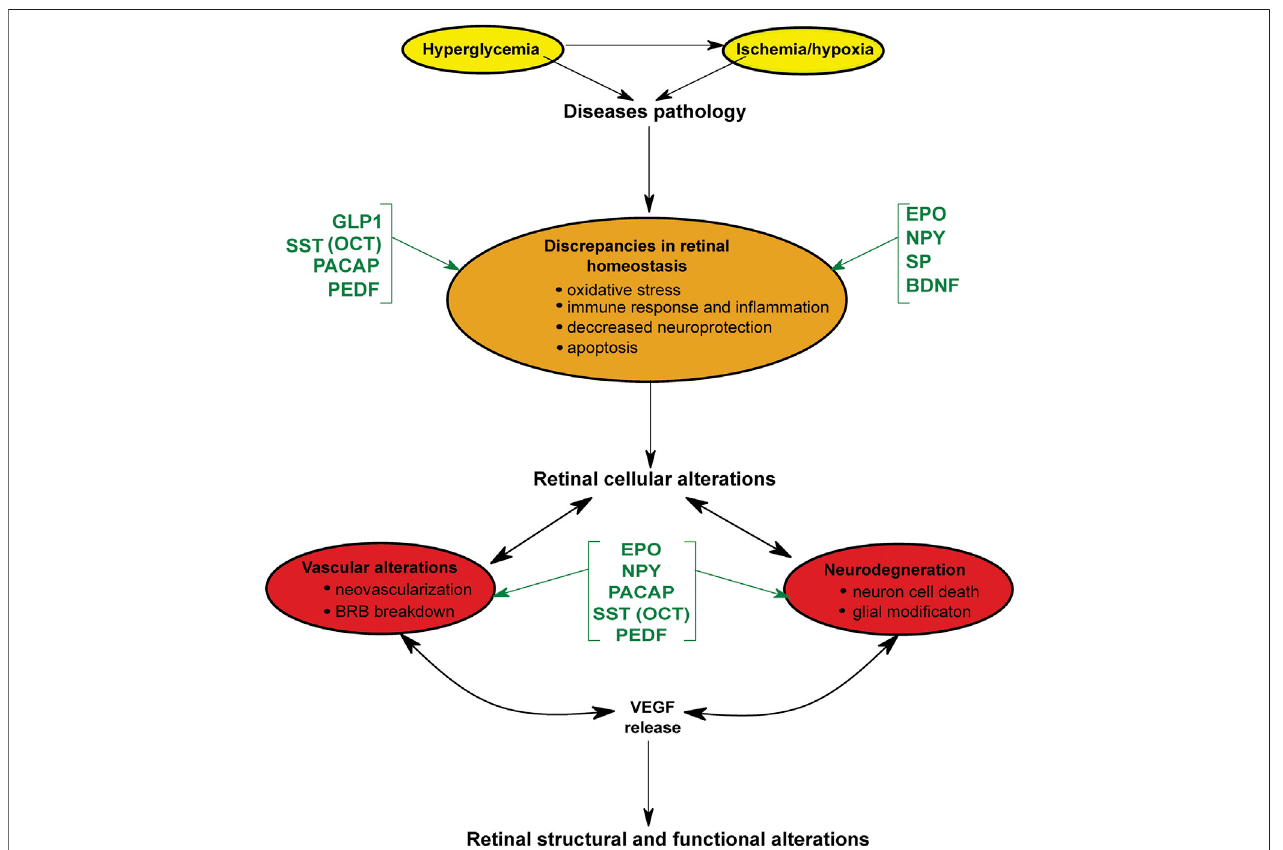
FIGURE 1 | Schematic representation of the curative role and point of action of different neuropeptides and other factors in retinal diseases. Yellow: the initial emergency situation at the onset of disease. Orange: early alterations/damages occurring at cellular level. Red: irreversible damage that leads to pathological structural and functional alterations in the retina. Abbreviations: GLP-1, glucagon-like peptide-1; SST, somatostatin; OCT, octreotide; PACAP, pituitary adenylate cyclase- activating polypeptide; PEDF, Pigment epithelium-derived factor; EPO, erythropoietin; NPY, neuropeptide Y; SP, substance P; BDNF, brain-derived neurotrophic factor; VEGF, Vascular endothelial growth